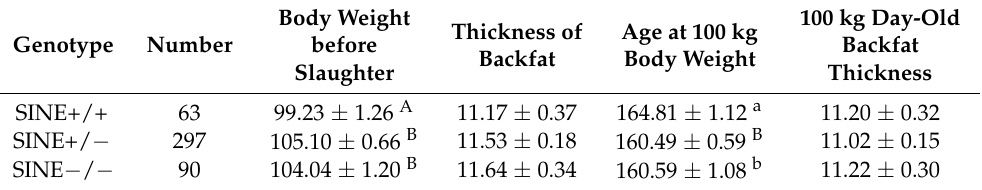
Table 3. Correlation between LEPROT -SINE-RIP polymorphism and growth traits of Large White